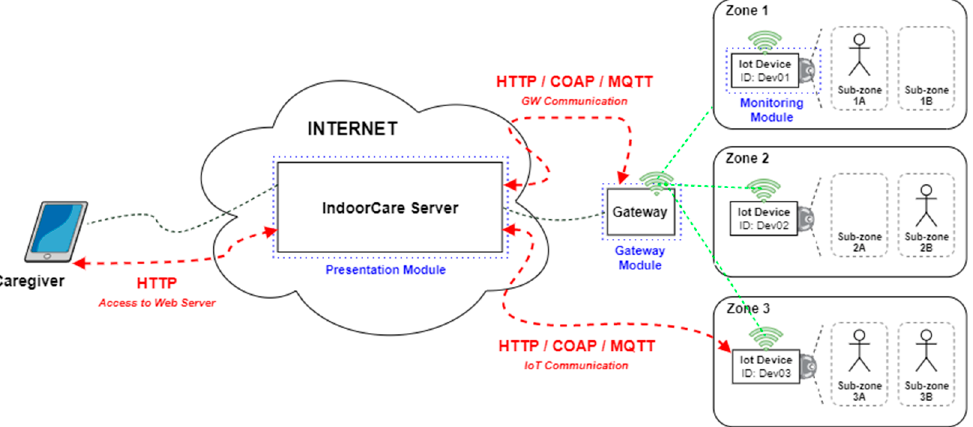
Figure 1. IndoorCare conceptual architecture.